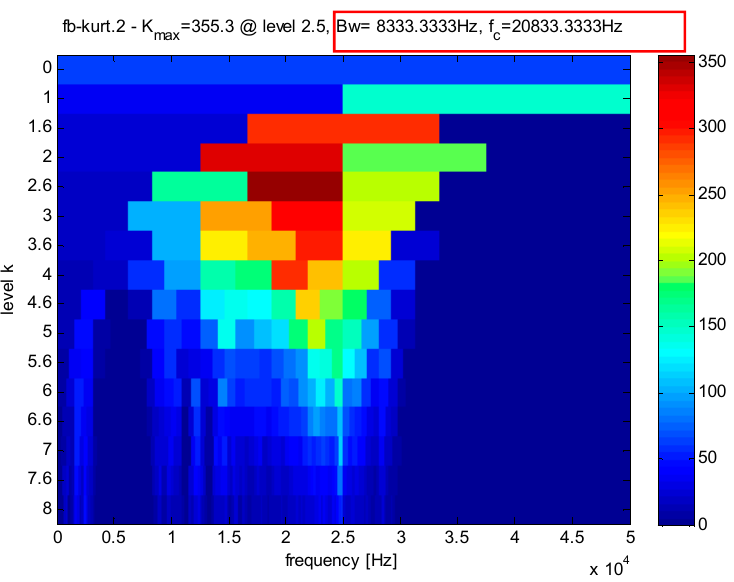
Figure 20. Second detection result using the raw signals based on the method in [37].